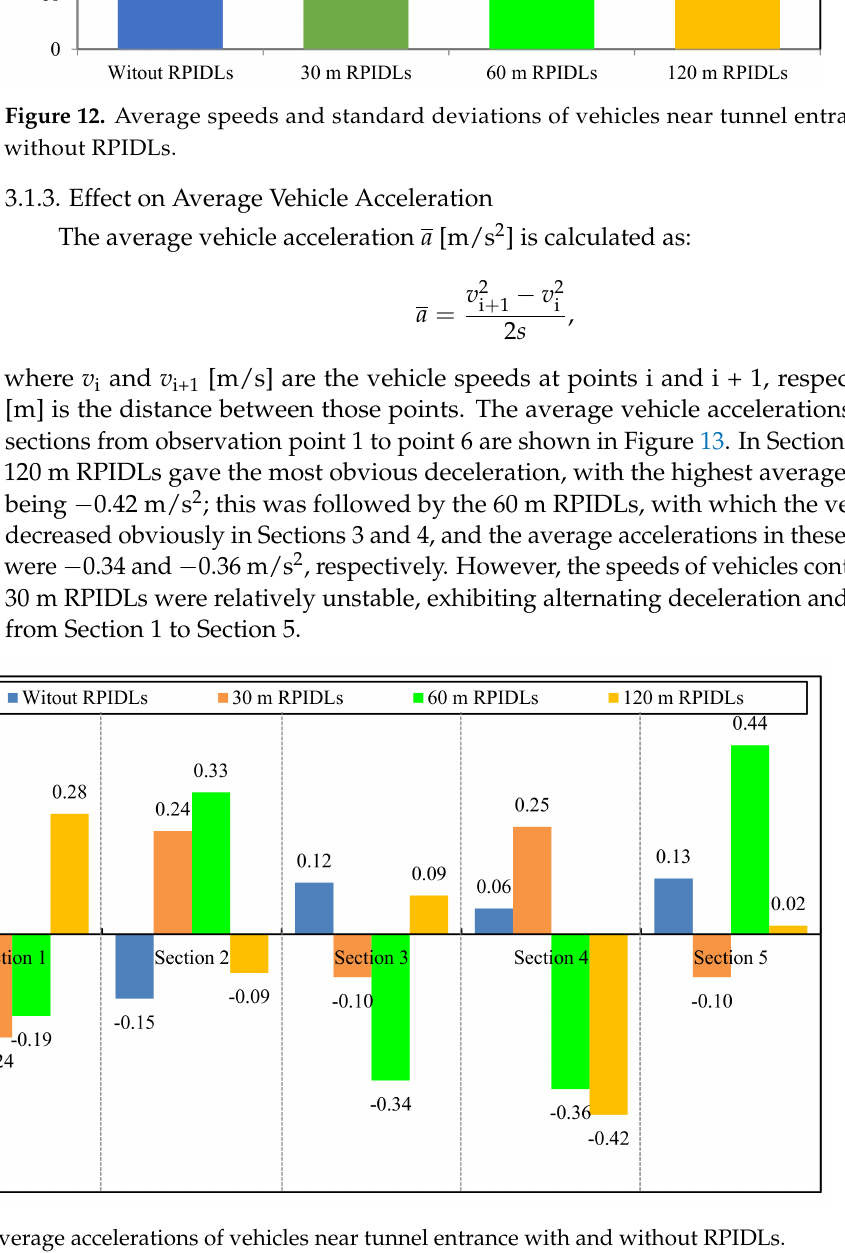
Figure 13. Average accelerations of vehicles near tunnel entrance with and without